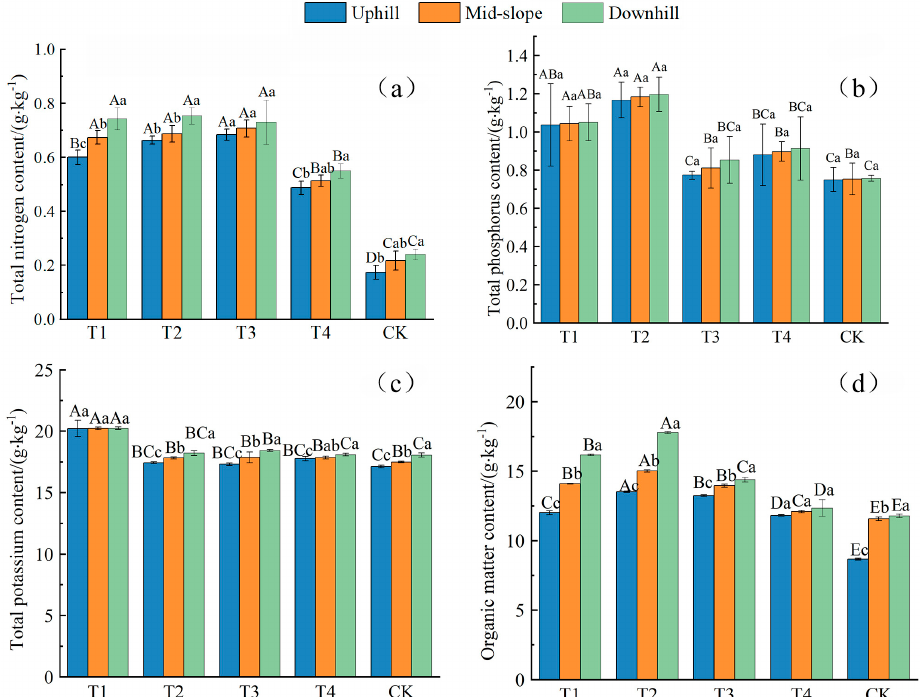
Figure 2. Effects of different hedgerow patterns on soil nutrients. Effects of different hedgerow patterns on total nitrogen content ( a ). Effects of different hedgerow patterns on total phosphorus content ( b ). Effects of different hedgerow patterns on total potassium content ( c ). Effects of different hedgerow patterns on organic matter content ( d ). Note: Different capital letters at the top of the his- togram denote the significant differences in soil nutrients in different plots at the same slope position and the same soil layer ( p < 0.05). Different lowercase letters indicate the significant differences in soil nutrients at different slope positions at the same soil layer in the same plot ( p <